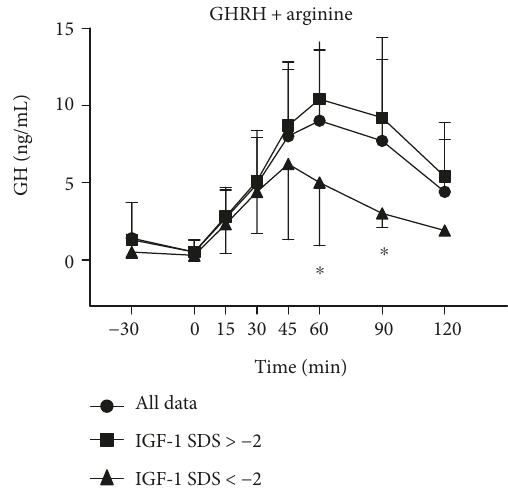
Figure 1: Serum concentrations of GH in FM obese patients (all data and subjects with normal or low IGF-1 SDS values), who underwent the combined GHRH plus arginine test. Data are expressed as mean ± SD. Please note that GH levels were signi fi cantly higher at T30, T45, T60, and T90 versus T0 ( p < 0 01 ) when considering all data and the two subgroups with normal or low IGF-1 SDS values. ∗ p < 0 05 versus the corresponding time point of the group with normal IGF-1 SDS values.